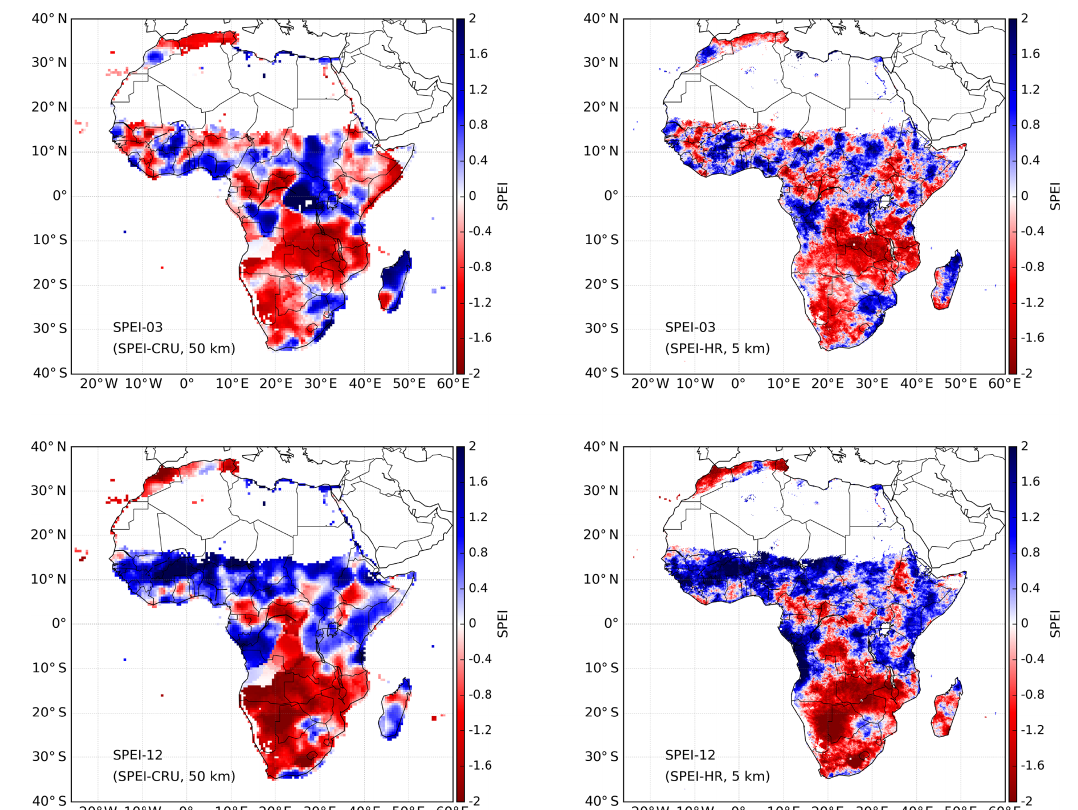
Figure 1. Spatial patterns of 3-month and 12-month SPEI at high spatial resolution (5km) and coarse spatial resolution (50km) in June 1995. The high spatial resolution SPEI (SPEI-HR) is based on CHIRPS precipitation and GLEAM potential evaporation, while the coarse spatial resolution SPEI (SPEI-CRU) is calculated from CRU TS